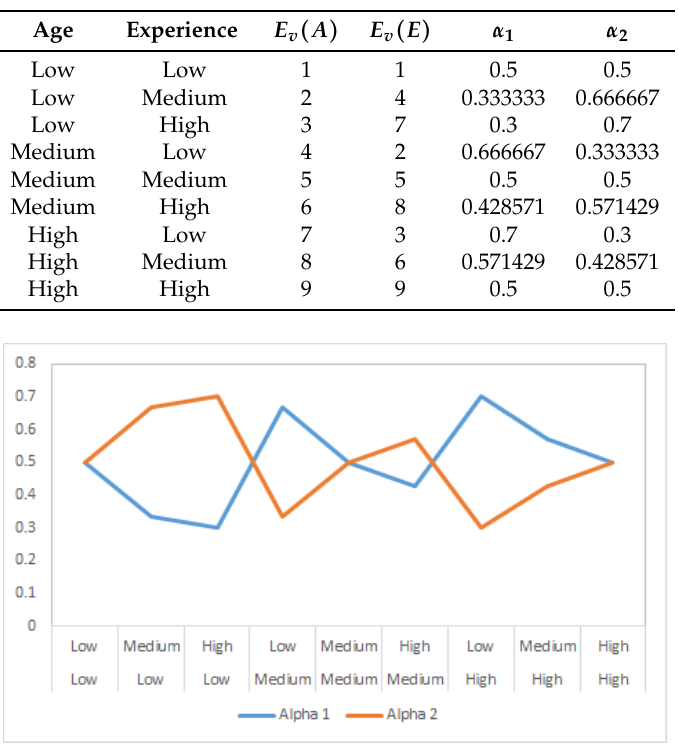
Figure 3. Adaptive weights values of α 1 and α 2